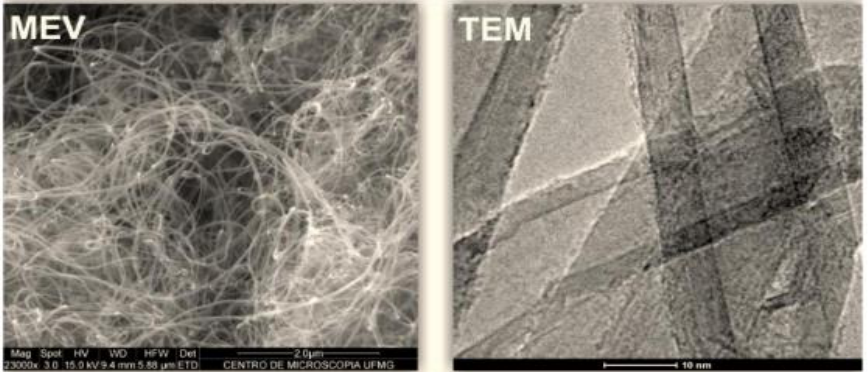
Figure 1. MEV and TEM images of CNTs used.